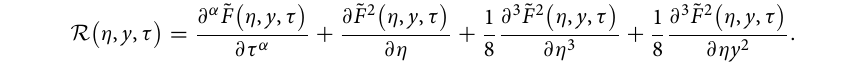
For finindg the C i , we used the least sqarue method. Using the mathematical values of convergence control parameters from Table 2 and put in (31), we get the first order approximate solution for different values of α for FZK (2,2,2). For α = 1.0